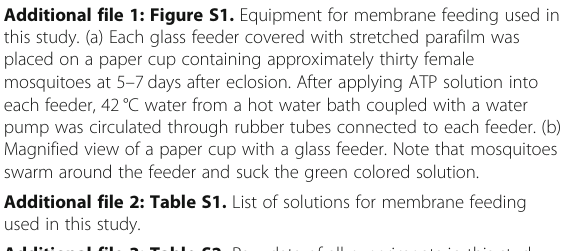
Additional file 3: Table S2. Raw data of all experiments in this